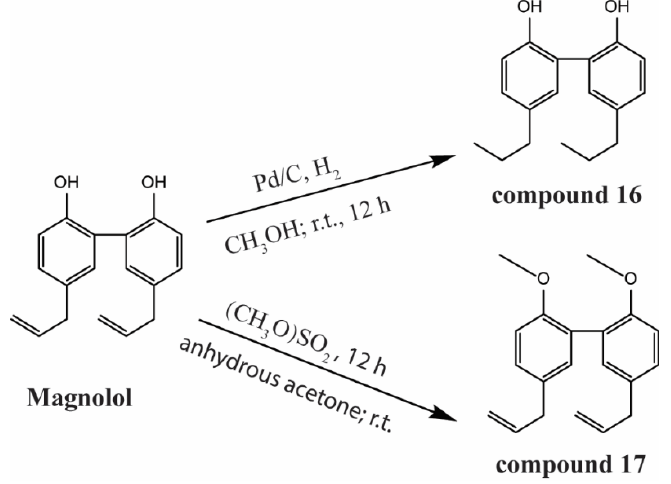
Figure 1. Reaction scheme showing the synthesis of compound 16 and compound 17 from magnolol.